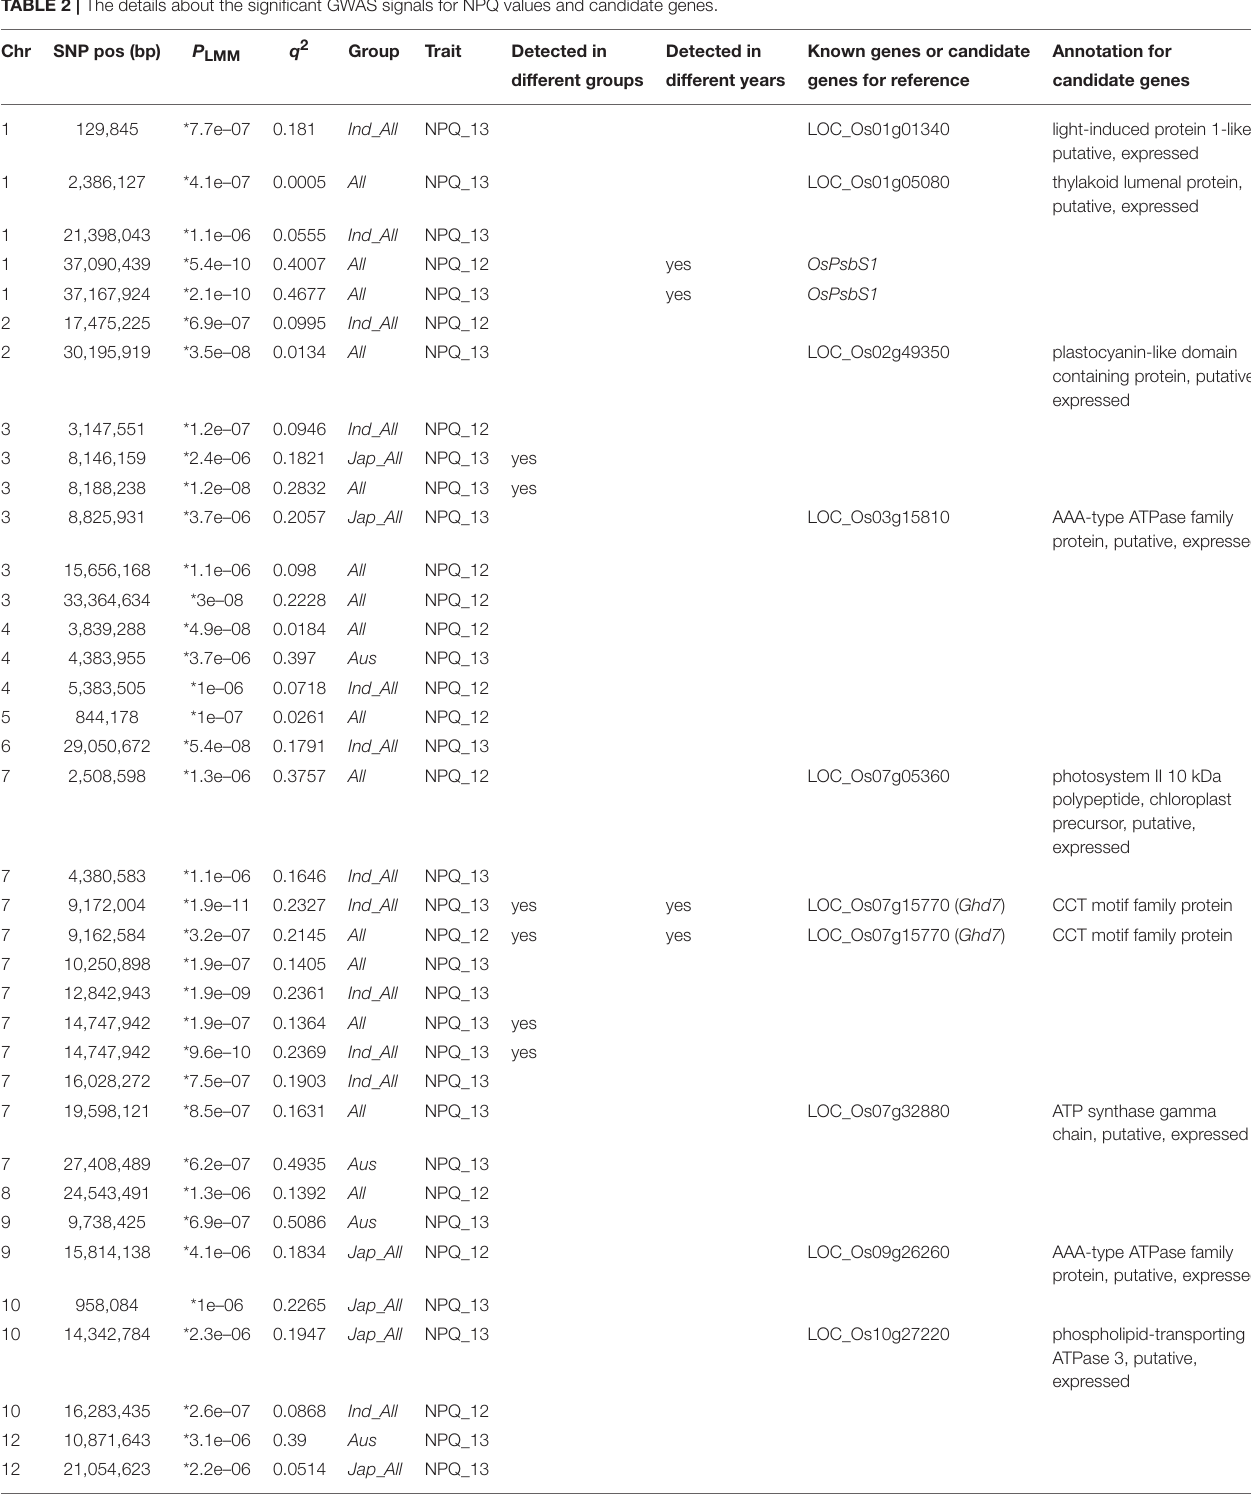
TABLE 2 | The details about the significant GWAS signals for NPQ values and candidate genes. Chr SNP pos